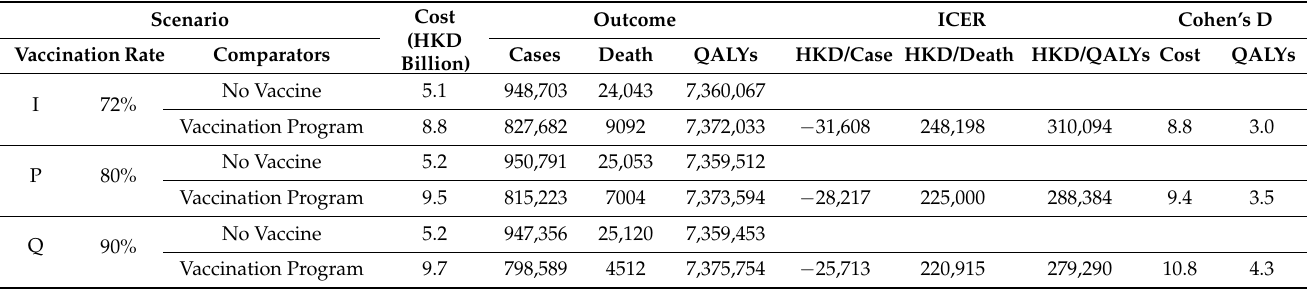
Table 5. Incremental cost-effectiveness ratio of the COVID-19 vaccination program adjusted for different vaccination rate under Omicron wave in Hong